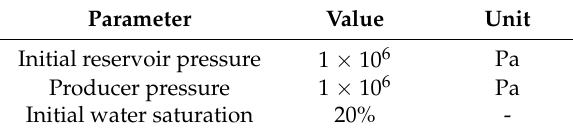
Table 3. Some parameters in simulations for Cases 2–4.